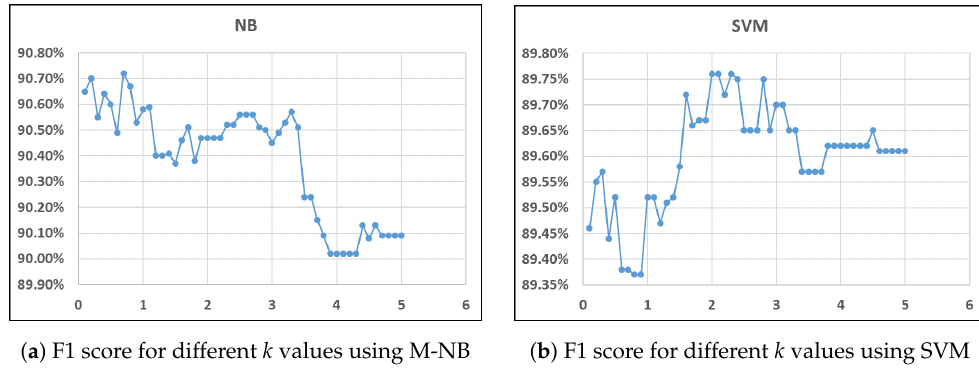
Figure 9. Results of all considered k values for MARSA (Sport) dataset.